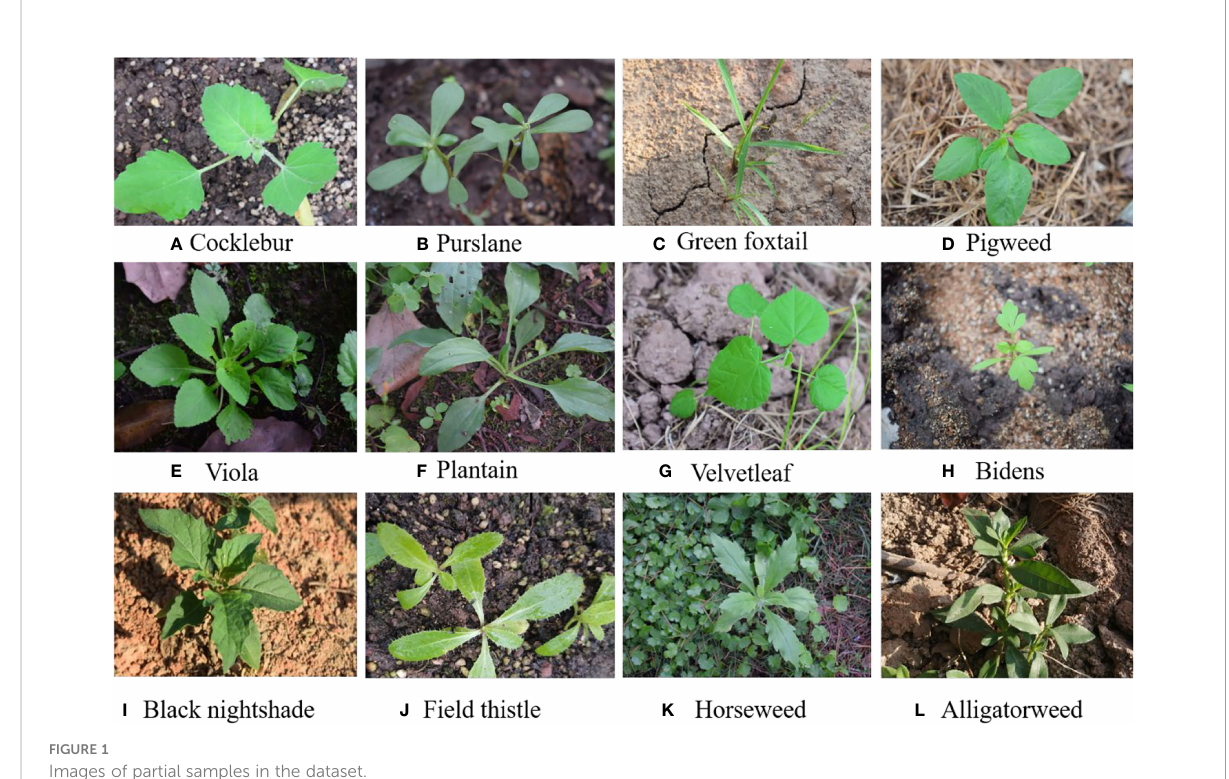
FIGURE 1 Images of partial samples in the